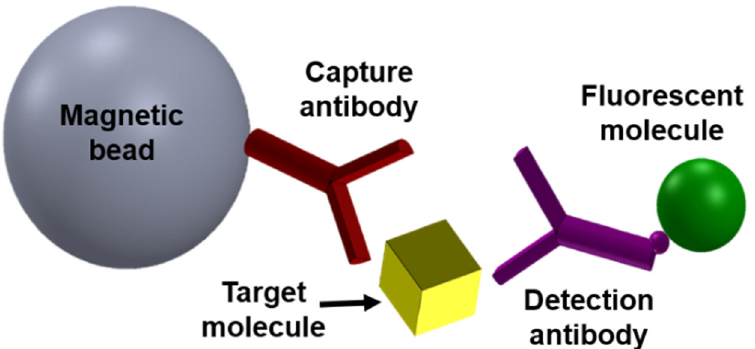
Figure 1. Schematic of a typical sandwich immunoassay. A typical fluorescence-based “sandwich” assay, showing a magnetic bead coated with a capture antibody, a target molecule (e.g., human interleukin 8), and a detection antibody conjugated to a fluorescent molecule (e.g., phycoerythrin). Reprinted from [15], with the permission of AIP Publishing 2019.